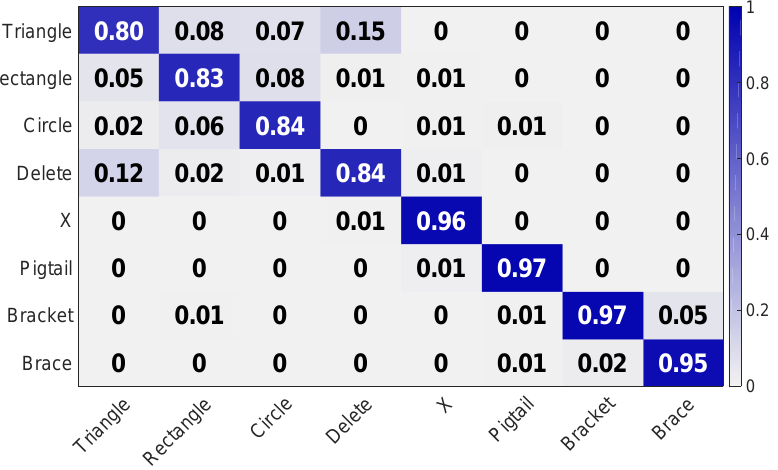
Figure 17. Confusion matrix for the unistroke gesture set. The columns refer to the actual class, and the rows to the assigned ones during the